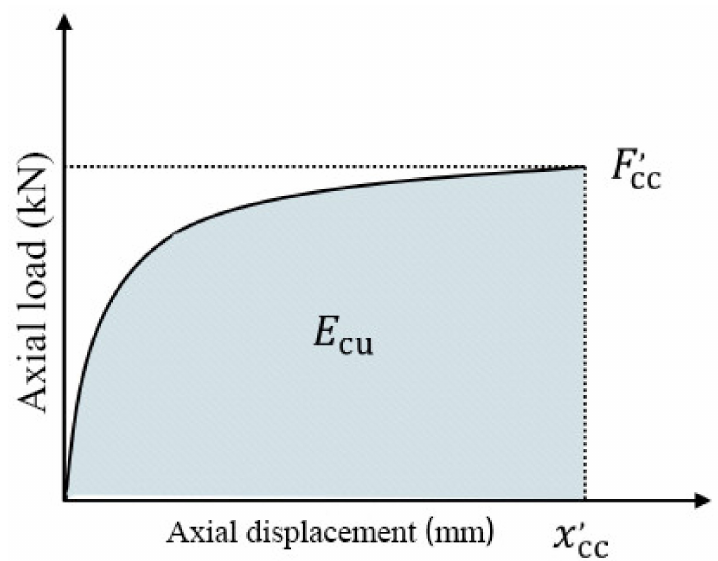
Figure 6. Schematic diagram of fracture energy